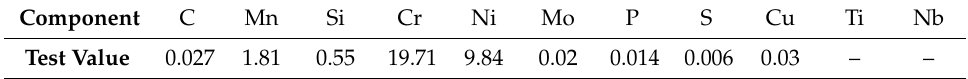
Table 1. Chemical composition of ER-308 stainless steel solid welding wire (%).